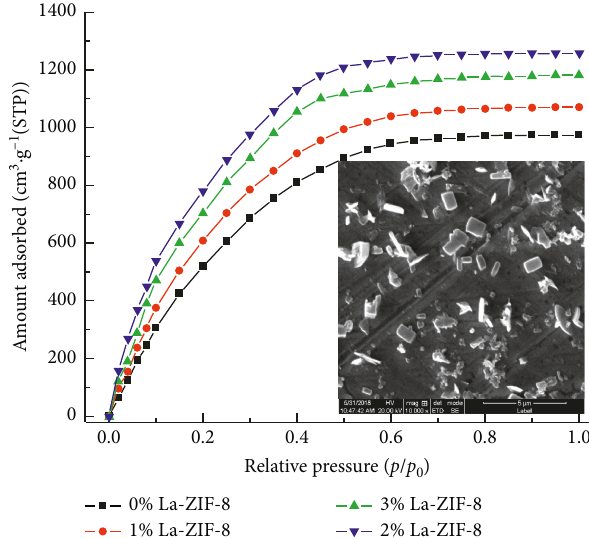
Figure 5: The CO 2 adsorption property of ZIF-8 and La-ZIF-8.